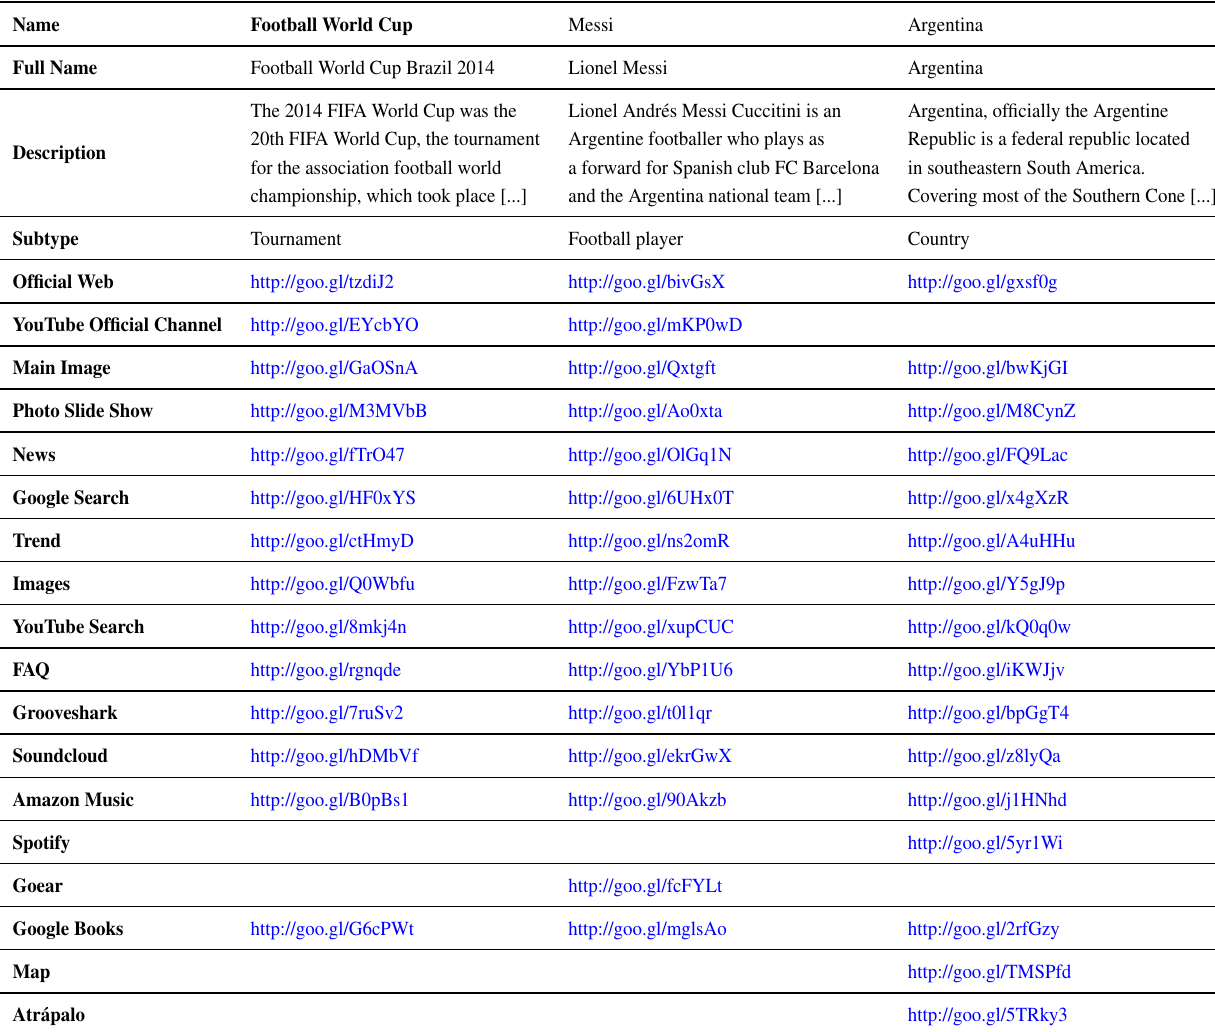
Table 3. Results obtained by the Information Enrichment module for the user utterance: Hi! Yesterday, some friends and I were watching the Football World Cup at my house. Argentina’s game was great but Messi didn’t play